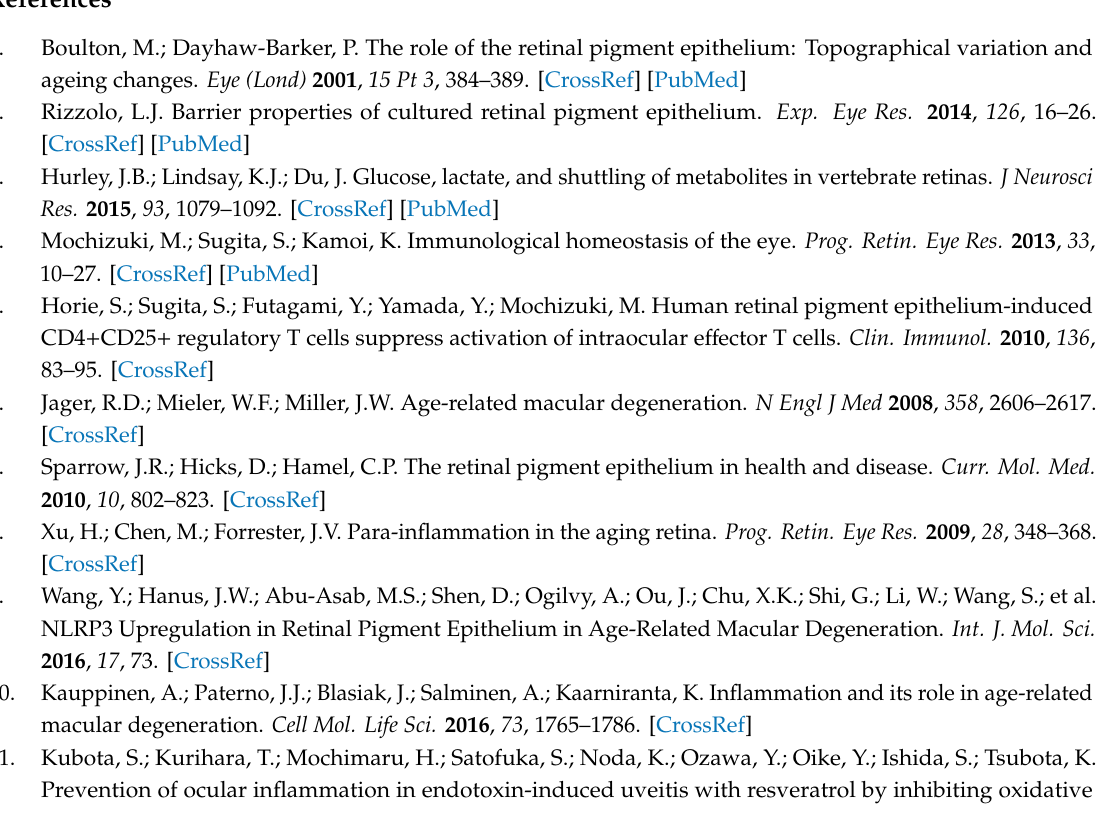
Figure S1. Cytokine production of LPS-treated APRE-19 cells. Figure S2. Reproducibility of global proteomic quantification. Figure S3. Hierarchical clustering of the identified phosphoproteins with di ff erential phosphosite intensities. Figure S4. Western blot analysis of proteins and phosphoprotein included in the pathways related to inflammation-driven pathogenesis in ARPE-19 cells. Table S1. List of the identified protein in global proteomic analysis. Table S2. List of di ff erentially expressed proteins (DEPs; q value < 0.05). Table S3. A subset of proteins and pathways which showed more than a 1.5-fold change in abundance after LPS challenge for 24 h (adjusted p value < 0.05). Table S4. List of the identified phosphopeptides. Table S5. List of the quantified phosphopeptides. Table S6. List of di ff erentially phosphorylated proteins (DPPs; p value < 0.05). Table S7. Enriched GO biological process pathways in protein abundances of LPS-treated ARPE-19 cells compared to untreated controls (FDR < 0.05). Table S8. Enriched GO biological process pathways within each cluster of LPS-stimulated ARPE-19 phosphoproteome (one-way ANOVA, p < 0.05). Table S9. Enriched GO biological process pathways within each cluster of LPS-stimulated ARPE-19 phosphoproteome (Student’s t test, p <